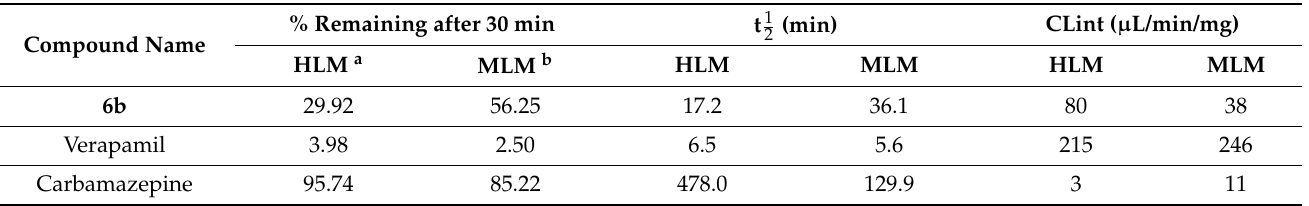
Table 1. Microsomal stability testing of compound 6b in HLM and MLM to assess in vitro intrinsic